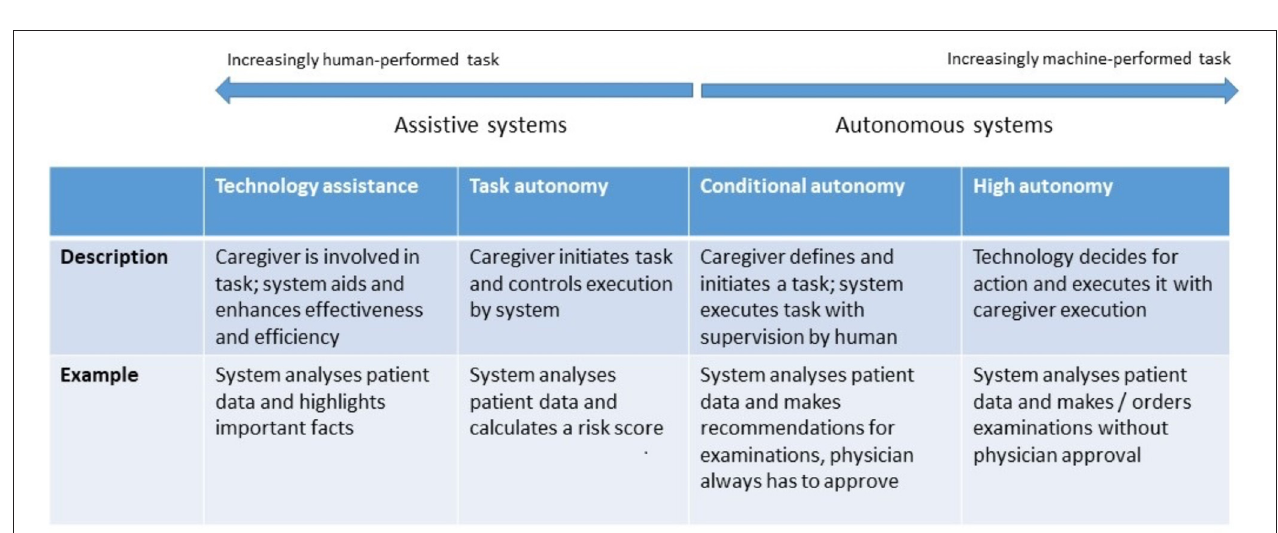
Robotics and AI for